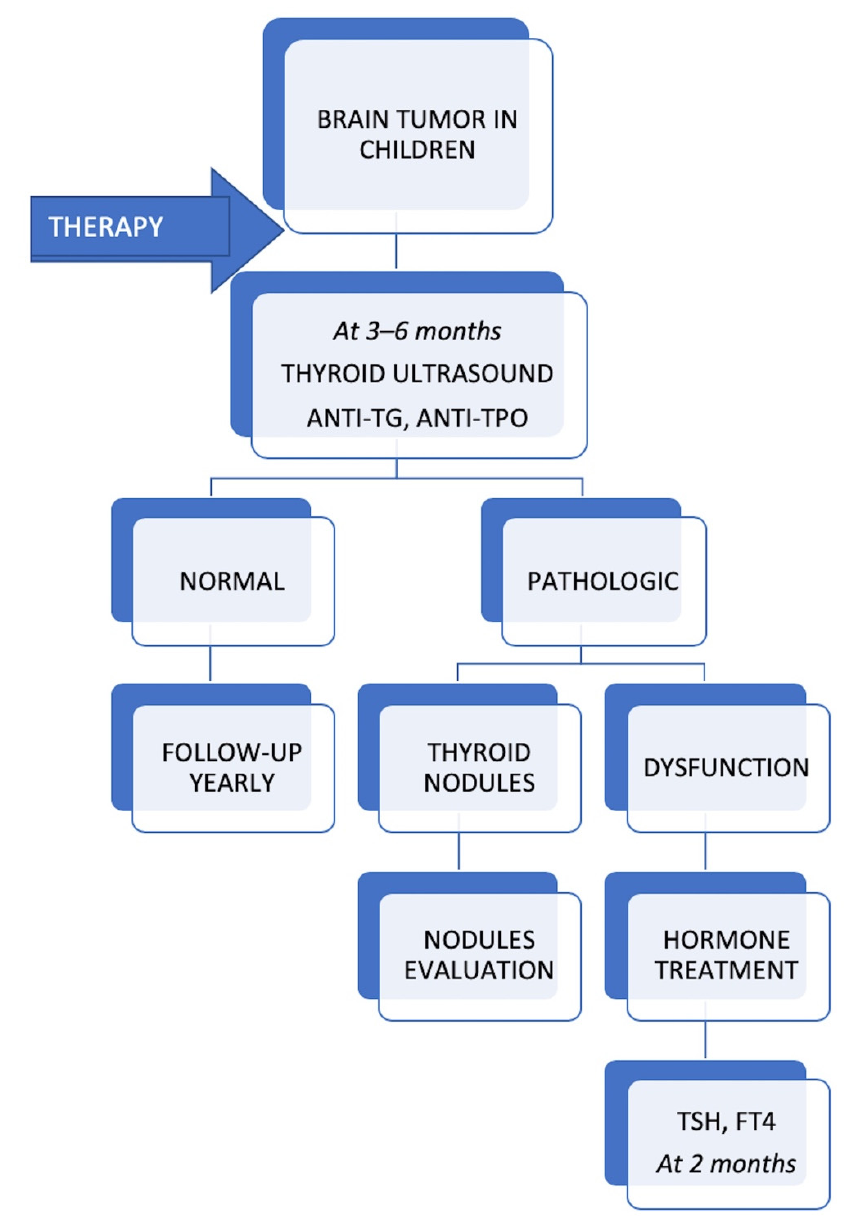
Figure 4. Protocol for monitoring the thyroid gland of children with brain tumors during follow-up.